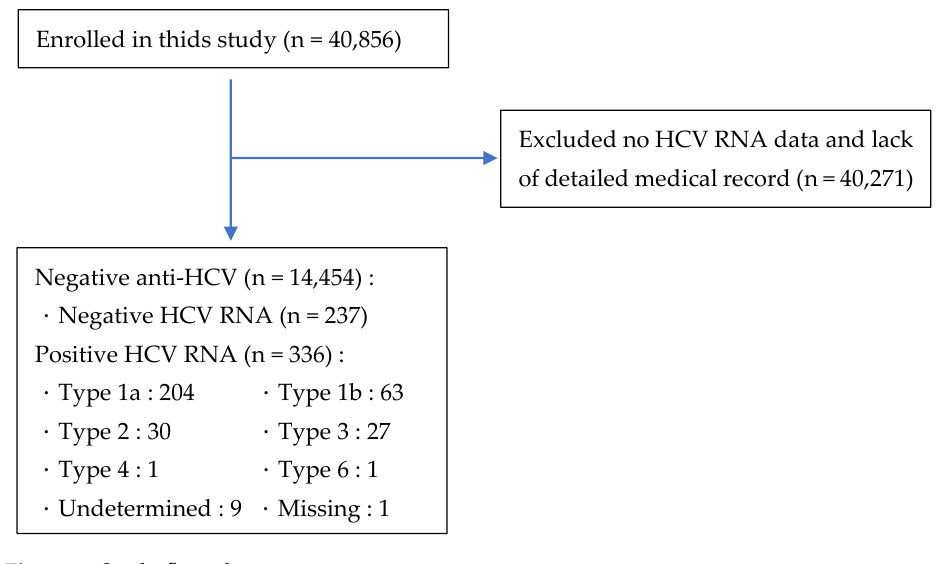
Figure 1. Study flow chart.